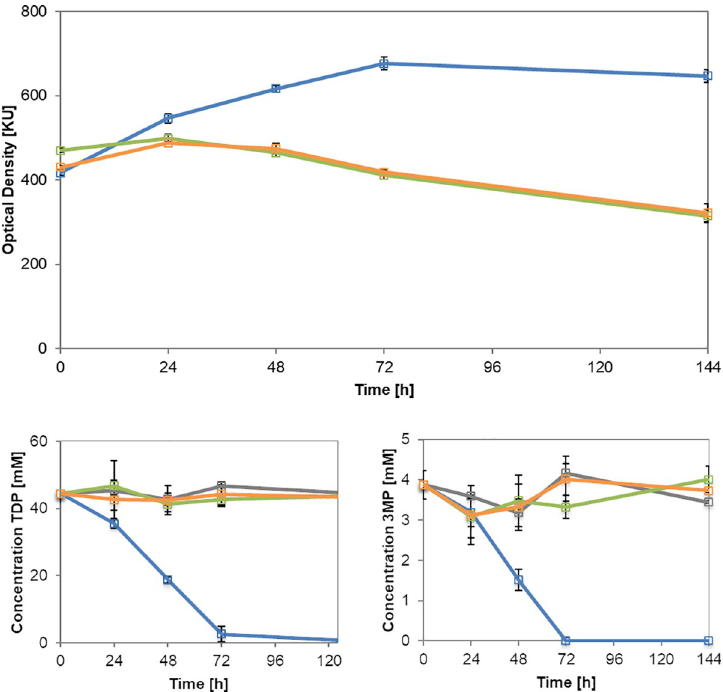
Fig 5. Supernatant analysis of the wildtype V . paradoxus TBEA6 in comparison to the mutants Δ ech-20 and Δ ech- 30 . Cell mass was generated with MSM containing 60 mM succinate for 26 h (not displayed in the graph). Medium was exchanged after reaching 400 Klett Unit [KU]; subsequently, cells were grown with 10 mM succinate and 50 mM TDP. Samples were withdrawn at t = 0, 24, 48, 72, 144 h and analyzed via GC. V . paradoxus TBEA6 (blue), V . paradoxus TBEA6 Δ ech-30 (green), V . paradoxus TBEA6 Δ ech-20 (orange). Top: growth curve after medium exchange; bottom left: TDP-concentration in the supernatant detected via GC; bottom right: 3MP-concentration in the supernatant detected via